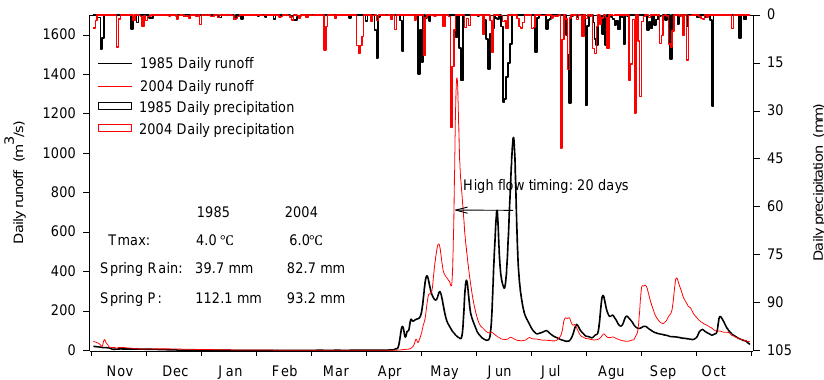
Figure 6. Hydrographs for the paired years of 1985 and 2004 in the UHR watershed.